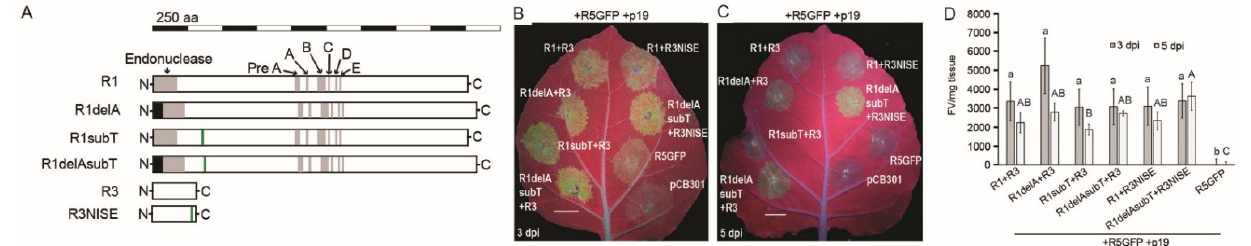
Figure 3. Mutagenesis analysis of RRV-GFP minireplicon. ( A ) Diagram of protein sequences and the location of the introduced mutations. The scale bar shows sectors representing 250 amino acids (aa). The name of the mutated protein is to the left. The gray boxes point to putative domains. The black boxes highlight the 21 amino acid extensions. The green boxes feature the poly T region in the nt sequence and the amino acid sequences FFFSF and IAKTV (R1subT), R1delAsubT has the deletion of adenine as well as substitution of the poly T region. Green boxes indicate another nt substitution to change the amino acid sequence from EFAL to NISE (R3NISE). ( B , C ) pCB301 constructs encoding the mutated RRV proteins in panel A were co-infiltrated into N. benthamiana in different combinations along with R5GFP +p19 and observed under UV light at 3 and 5 dpi. The white bars indicate 1 cm. The controls included R5GFP +p19 alone or the empty vector pCB301. ( D ) The infiltrated leaf patches were excised and used in fluorometry to quantify GFP fluorescence. The graph shows the average FV/mg- tissue and is representative of three experimental replicates ( n = 6). The lines through the bars represent the standard error of the mean. Multiple comparisons of the means were performed by ANOVA and Tukey’s HSD ( p < 0.05). Values with lowercase letters represent analysis across 3 dpi and uppercase letters represent 5 dpi. Mean values that are not statistically different are indicated by the same lowercase or uppercase letters.